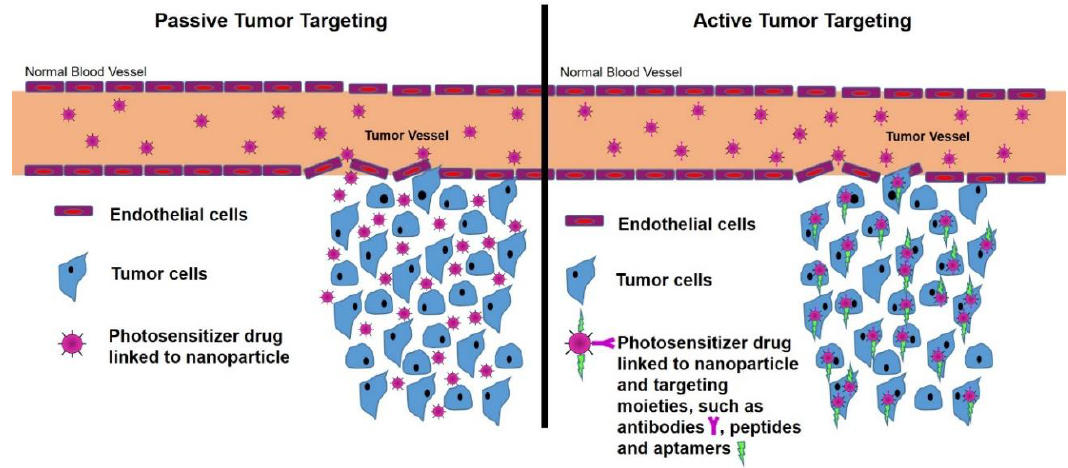
Figure 3. Passive and active forms of photosensitiser (PS) nano-drug tumour targeting and delivery strategies used for the PDT treatment of cancer.